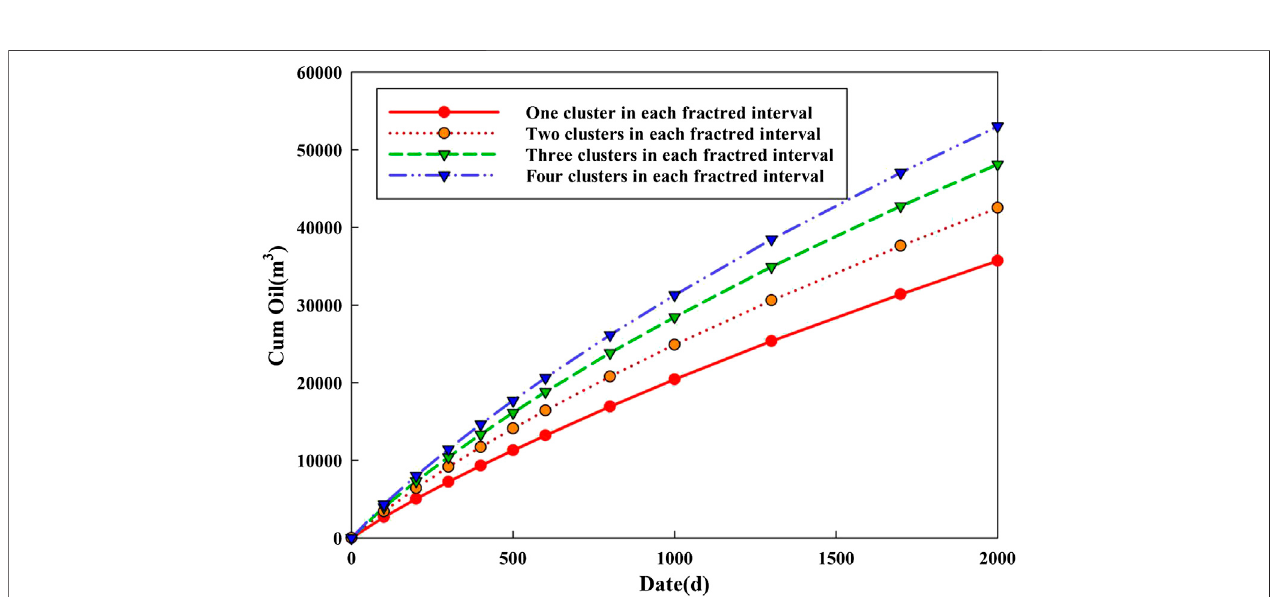
FIGURE 14 | Cumulative oil production curve of different number of fracture